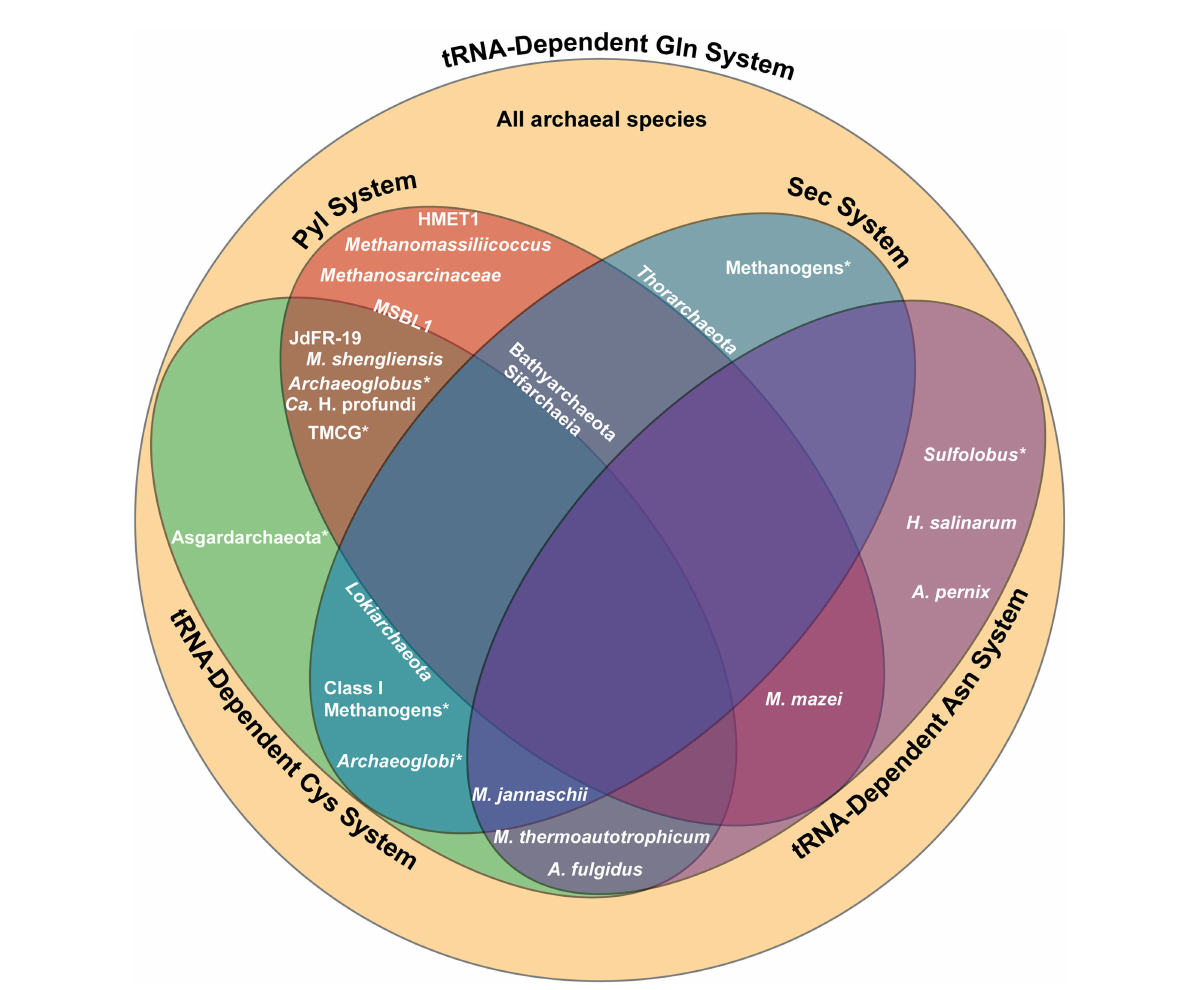
FIGURE 5 Summary of the genetic code systems found in various archaeal lineages. Lineages positioned within a section possess the complete machinery for the designated system, while those located on the border of a section possess only partial machinery. An asterisk (*) indicates that only certain species within the lineage utilize the specified system. All archaea utilize the tRNA-dependent Gln biosynthesis system. Gln, glutamine; Sec, selenocysteine; Pyl, pyrrolysine; Cys, cysteine; Asn, asparagine; TMCG, Terrestrial Miscellaneous Crenarchaeota group; HMET1, Candidatus Methanohalarchaeum thermophilum HMET1; JdFR-19, Methanomicrobia archaeon JdFR-19; MSBL1, Mediterranean Sea Brine Lakes 1 archaeon